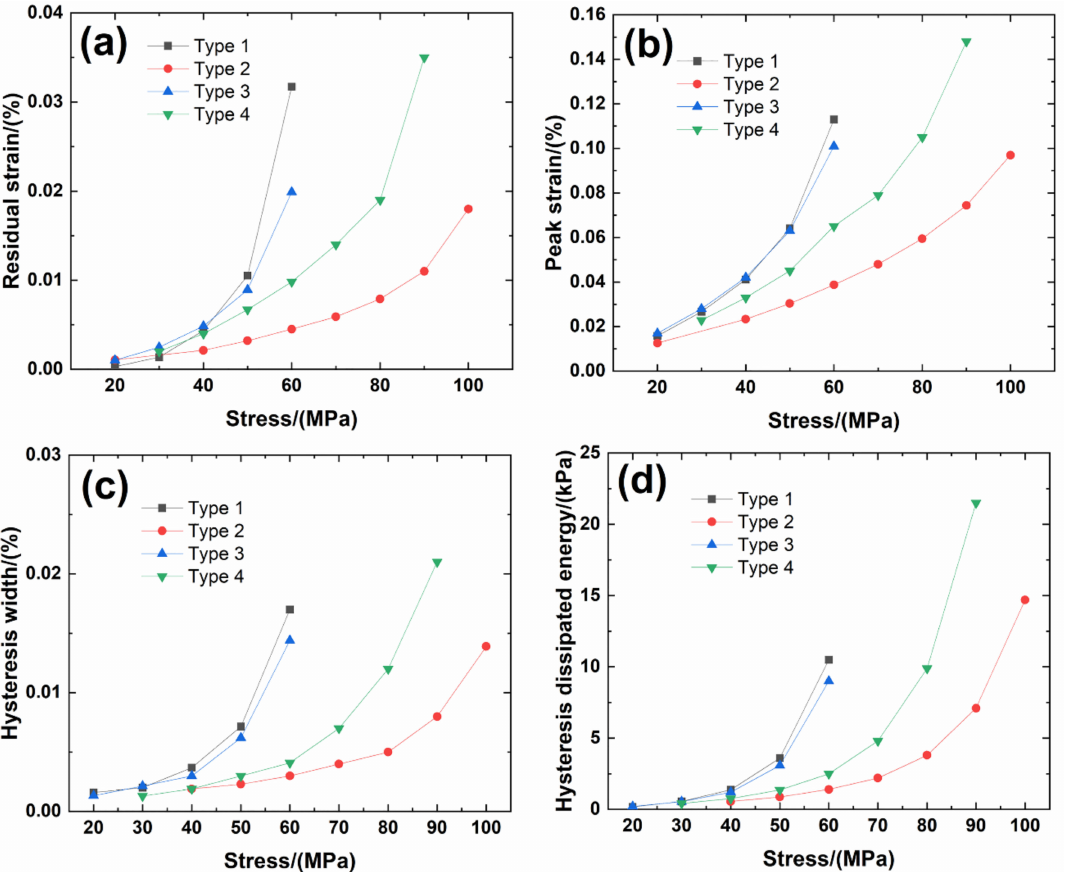
Figure 8. ( a ) Unloading ITM; ( b ) reloading ITM; ( c ) hysteresis width; and ( d ) hysteresis dissipated energy of Type 1 3D needle-punched C/SiC composite.